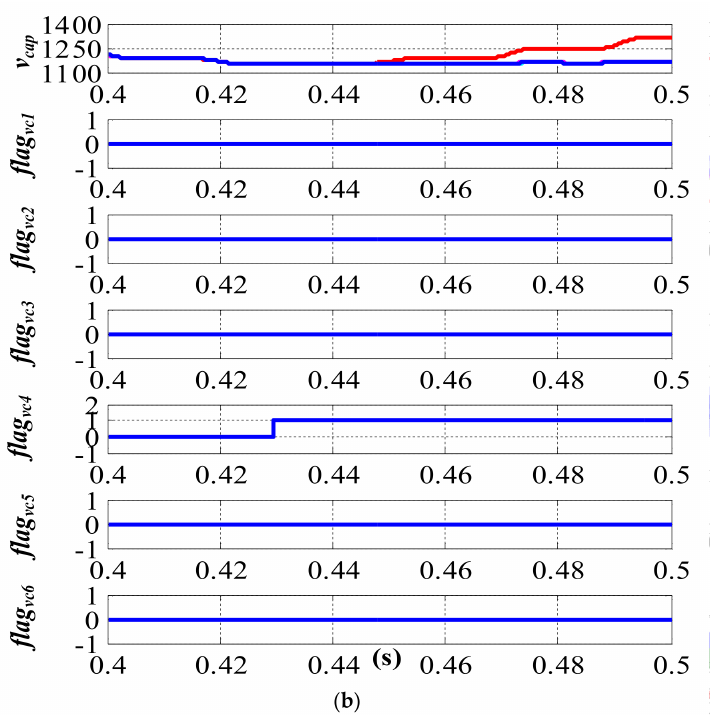
Figure 8. The fault localization module test. ( a ) The fault localization of the B phase upper bridge arm module with an S 1 open circuit fault; ( b ) The fault localization of the B phase upper bridge arm module with an S 2 open circuit fault.